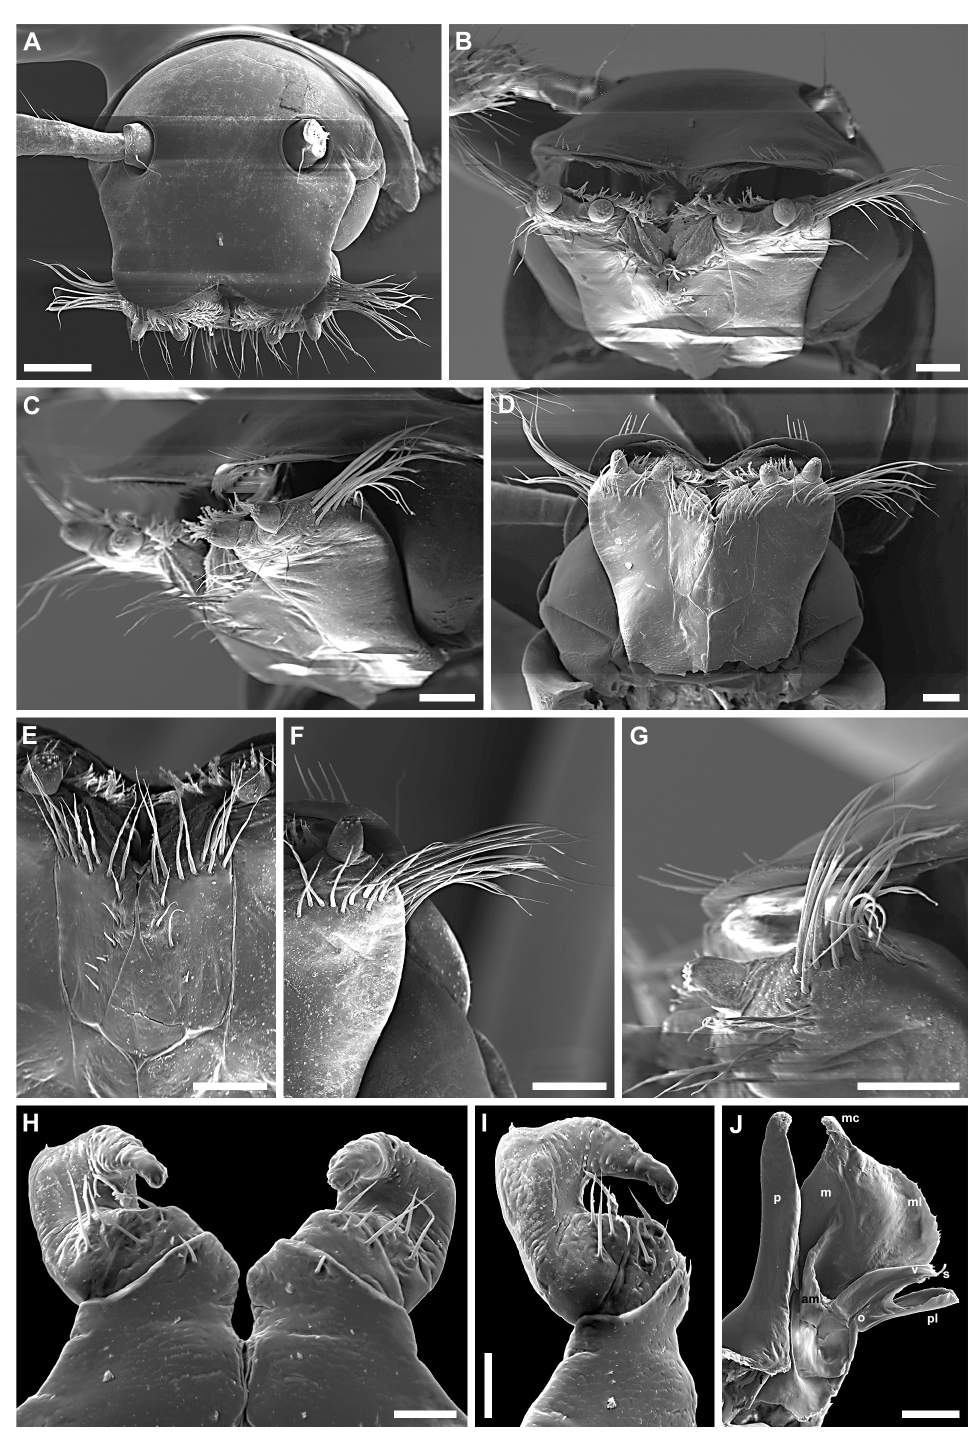
Fig. 40. Leucogeorgia mystax sp. nov., holotype ♂ from Nytshka Cave (ZMUM). A . Head, dorsal view. B . Head, anterior view. C . Head, anterolateral view. D . Head, ventral view. E . Lamellae linguales, ventral view. F . Left stipe, ventral view. G . Left stipe, lateral view. H . Leg-pair 1, anterior view. I . Left leg 1, lateral view. J . Left gonopods, mesal view. Abbreviations: am = accessory membrane; f = flagellum; m = mesomere; mc = mesomeral claw; ml = mesomeral lamella; o = opisthomere; p = promere; pl = protective lamella; s = solenomere; v = velum. Scale bars: A = 0.2 mm; B–G, J = 0.1 mm; H–I = 0.05